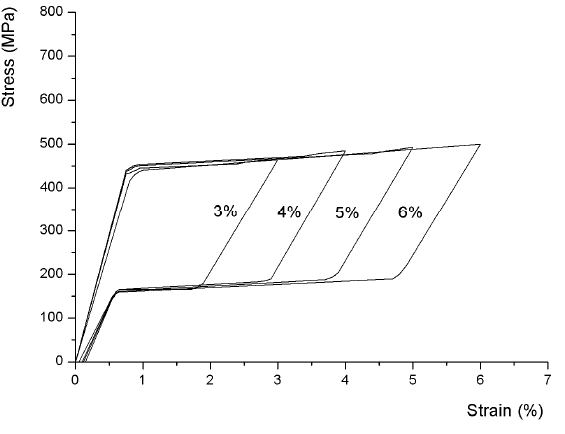
Figure 10 . The influence of various strain amplitudes on NiTi